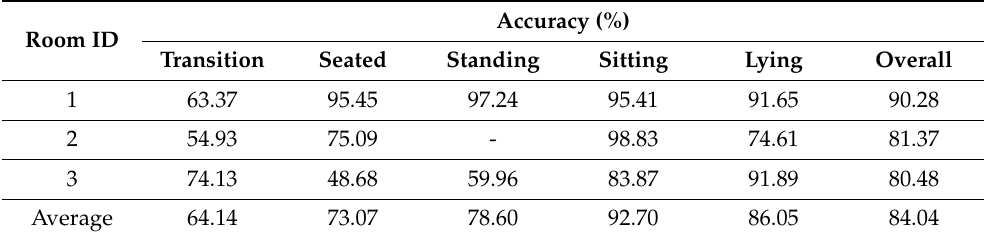
Table 6. Accuracy for each specific action tested with the SVM + HMM